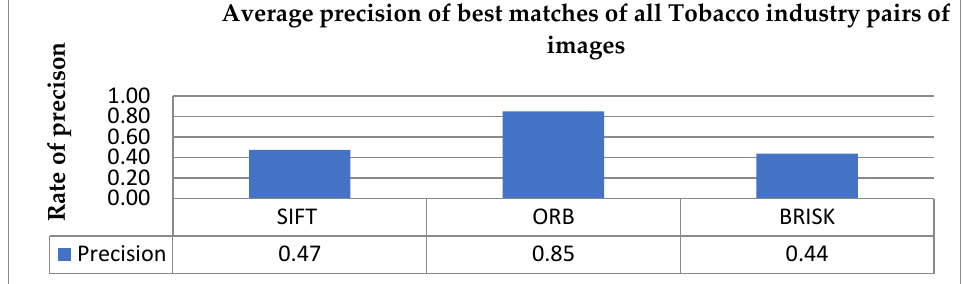
Figure 22. Average precision matching from all pairs of images.